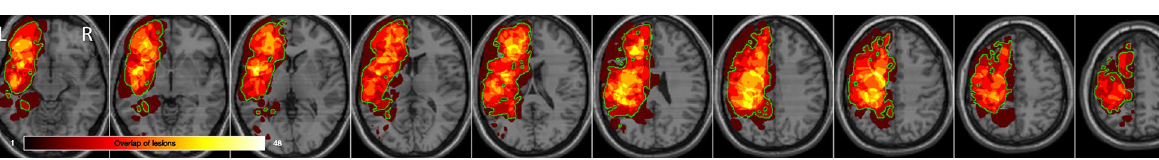
Figure 4. Map depicting regions in which at least two participants had overlapping lesions, projected on the standard-space Montreal Neurological Institute template (MNI152), total n = 48. Regions in which actual overlap occurred and where the analysis was restricted to is outlined in green. Accordingly, five participants with non-overlapping right-sided tumors were excluded from lesion-symptom